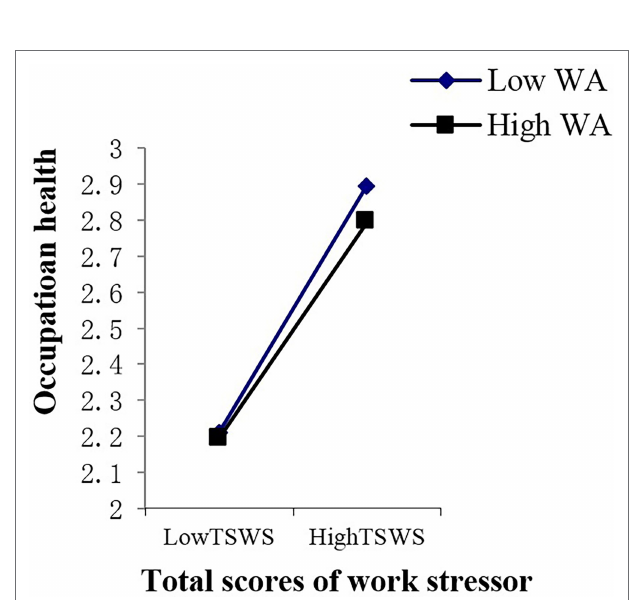
FIGURE 6 | Interactive effects of WA and TSWS on OH. WA, work adaptability; TSWS, total scores of work stress; OH, occupation